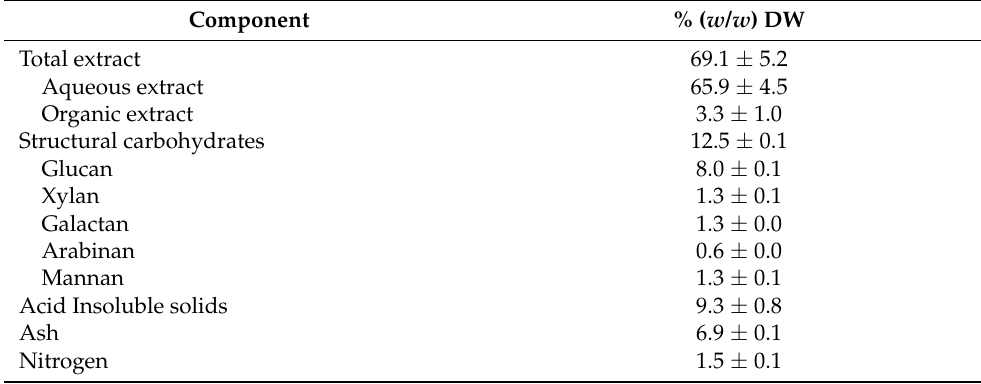
Table 6. Chemical composition of culled tomato residue. Data expressed as percentage ( w/w ) on a DW